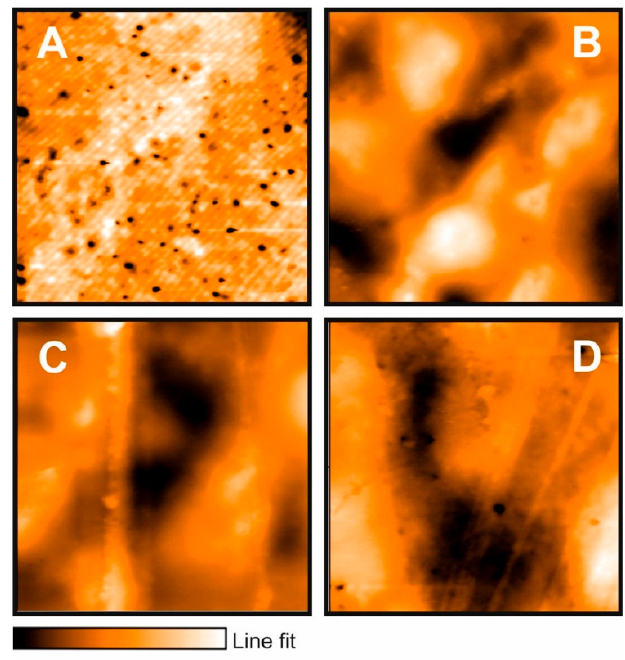
Figure 3. Representative AFM micrographs of ( A ), starch ( B ), starch/halloysite, ( C ) starch/halloysite/Mexican oregano ( Lippia berlandieri Schauer) essential oil 1%, and ( D ) starch/halloysite/Mexican oregano ( Lippia berlandieri Schauer) essential oil 2%. Conditions: Static force, set point 55 nN. Area: 50 × 50 μ m. Line fit (color intensity): Line fit ( A ) 0.2 μ m, ( B ) 0.96 μ m, ( C ) 1.35 μ m, ( D ) 1.37 μ m.